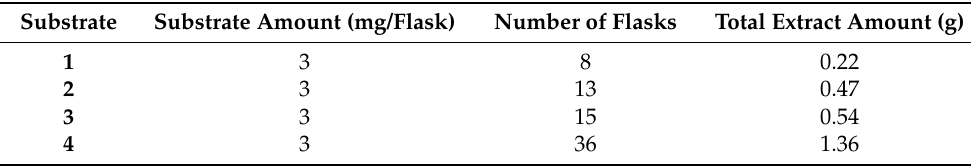
Table 5. Scale-up fermentation of substrates with A. niger